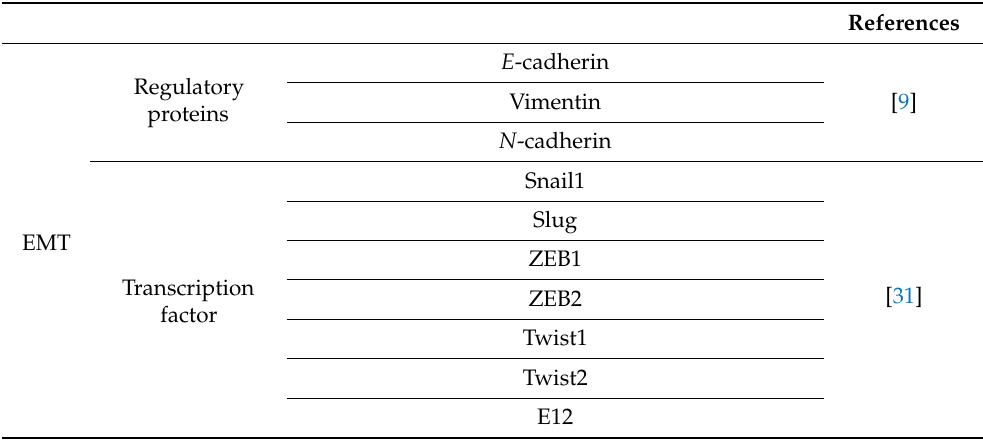
Table 1. EMT-related factors and drugs for targeted